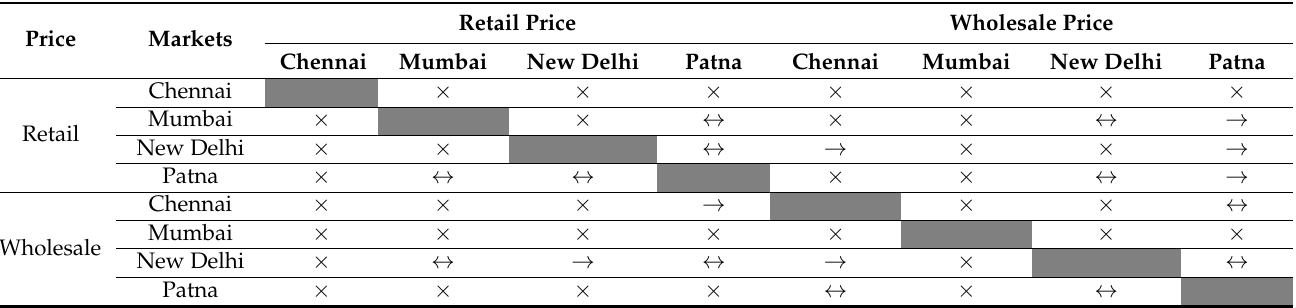
Table 11. Price transmission between the wheat markets by Granger causality test.